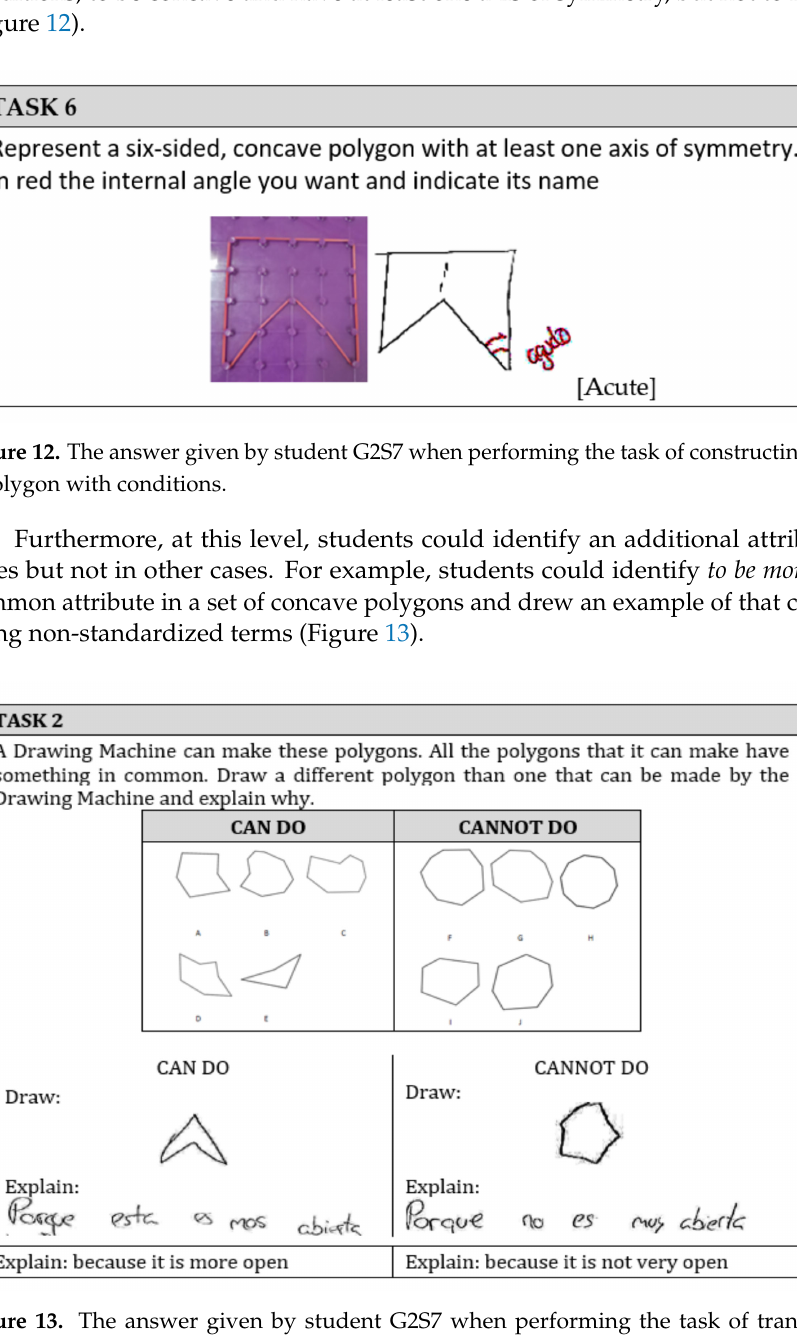
Figure 13. The answer given by student G2S7 when performing the task of transforming non- polygons into